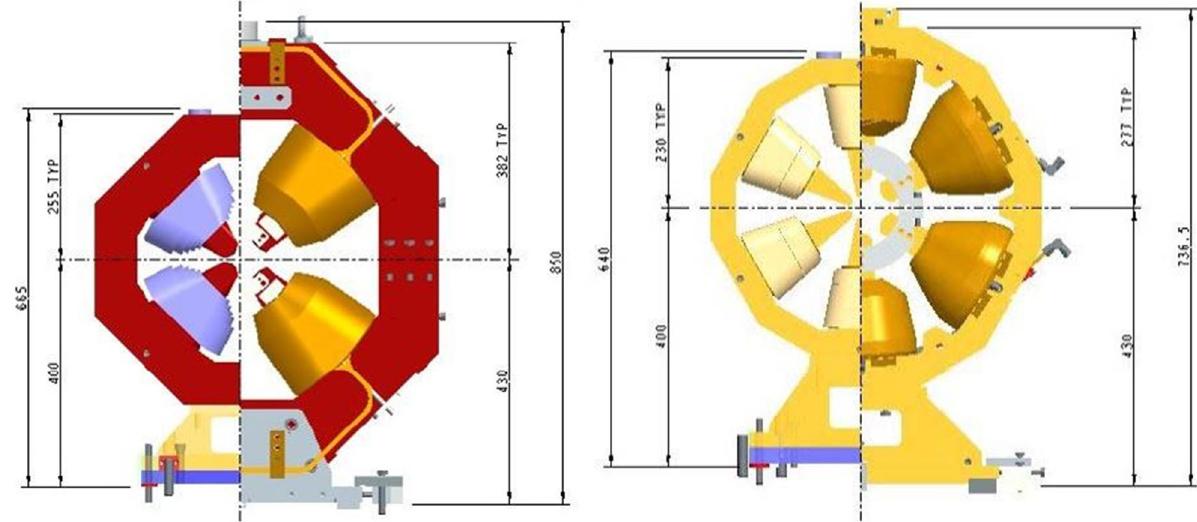
FIG. 7. Cross sections of quadrupoles and sextupoles in the existing DBA cell (right halves) and DDBA cell (left halves).